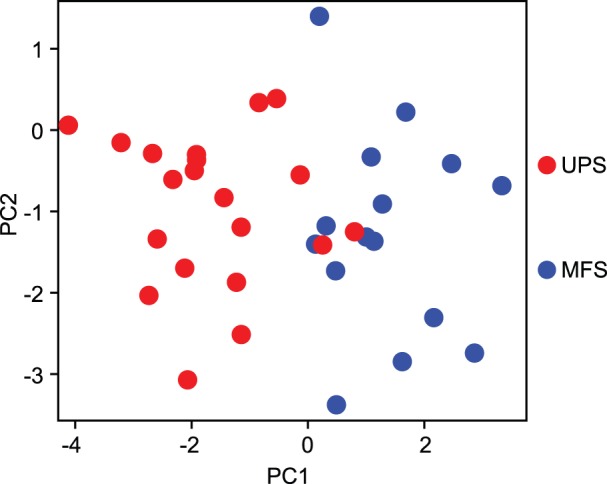
Principal component analysis using 9 probe sets for UPS and MFS.The x-axis and y-axis represent the first and second principal components (PC1 and PC2), respectively. Each dot represents a sample colored according to its histological type. UPS: undifferentiated pleomorphic sarcoma, MLS: myxoid liposarcoma, SS: synovial sarcoma, MFS: myxofibrosarcoma.